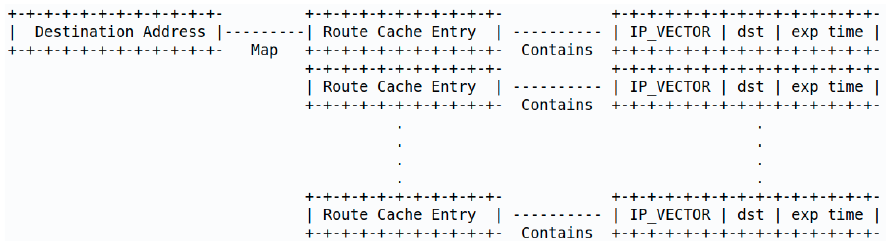
Figure 1. Route cache structure